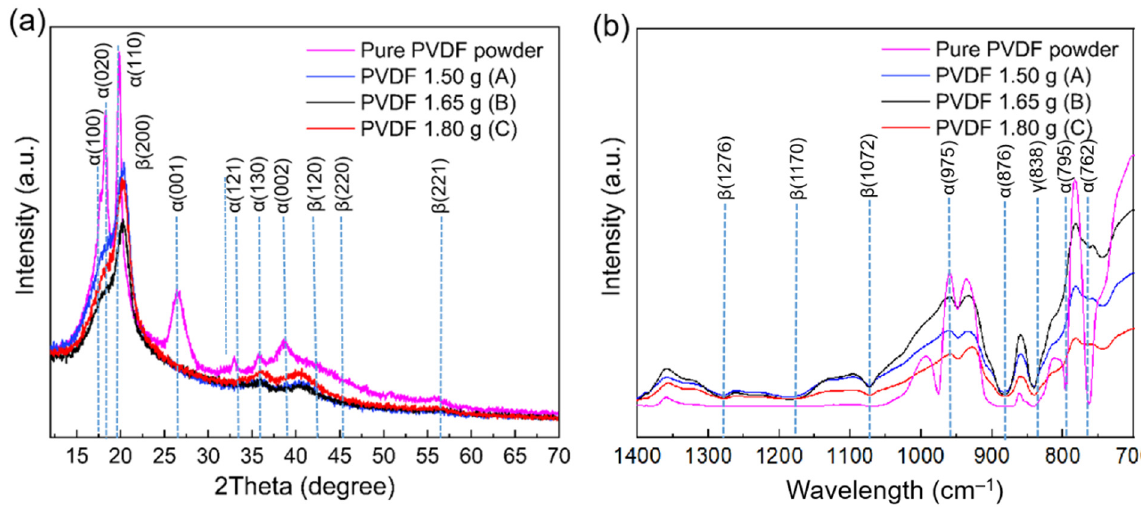
Figure 4. ( a ) XRD profiles of pure PVDF powder and electrospun fibers of different concentrations of PVDF and ( b ) FTIR spectrograph for PVDF powder including α - and γ -phases, and three different concentrations of electrospun PVDF nanofibers including β -phase.